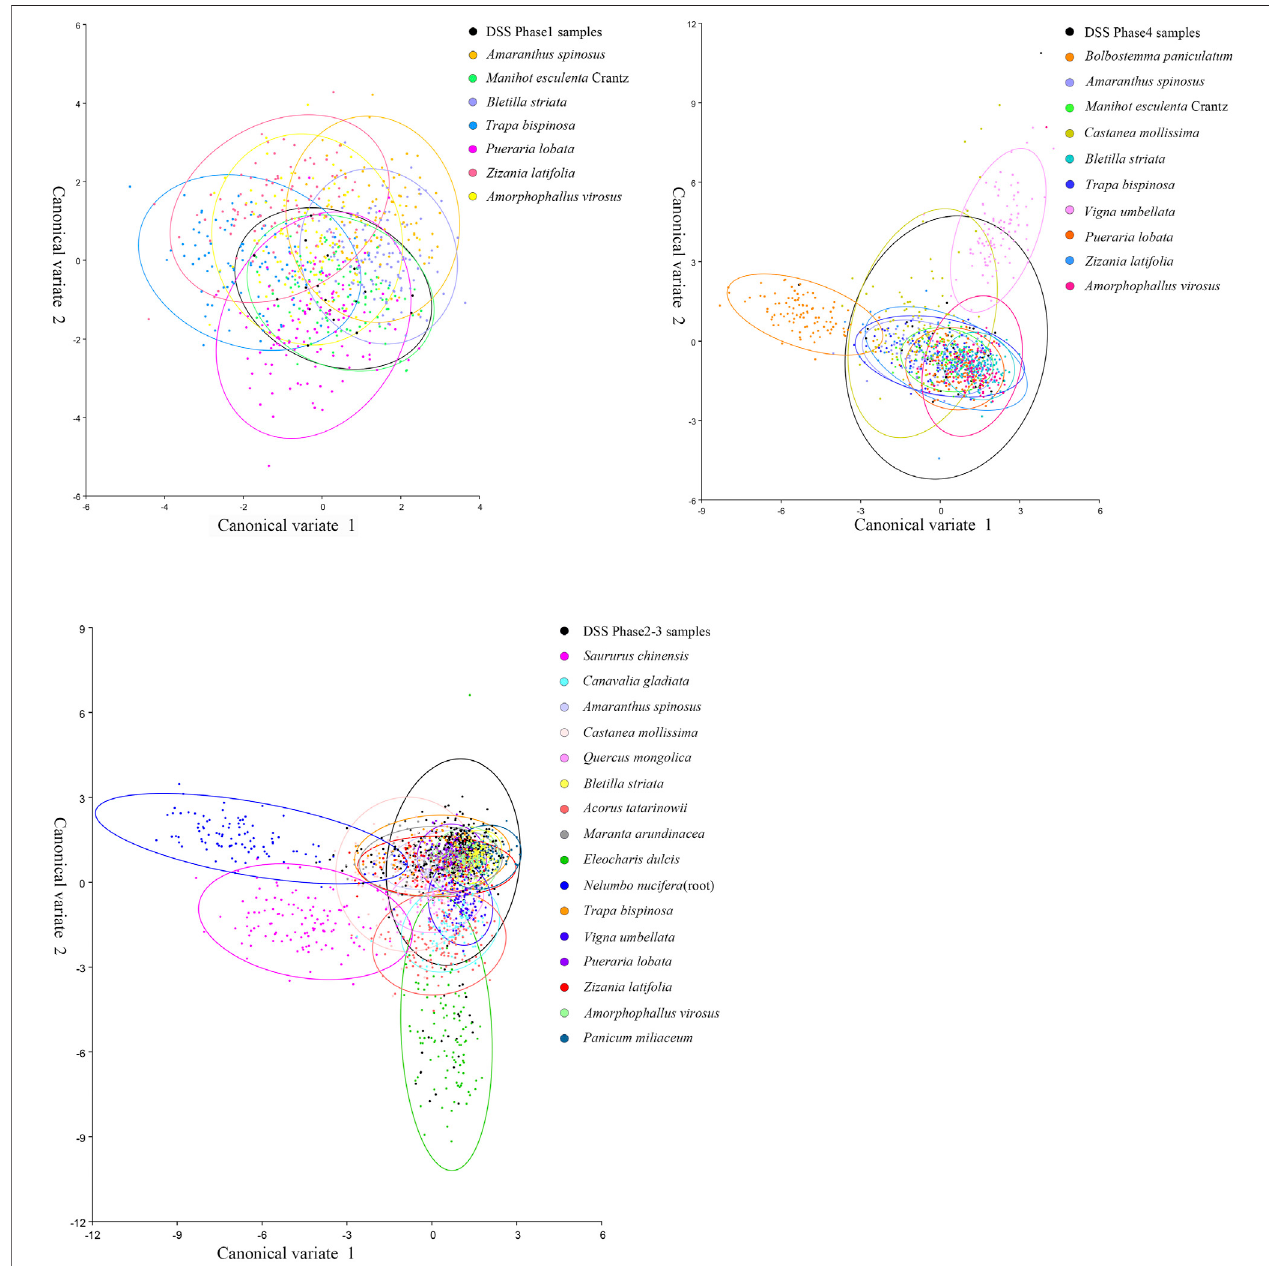
FIGURE 6 | Con fi dence ellipses (probability = 0.95) based on Canonical Variate scatter plot of CV1 and CV2.